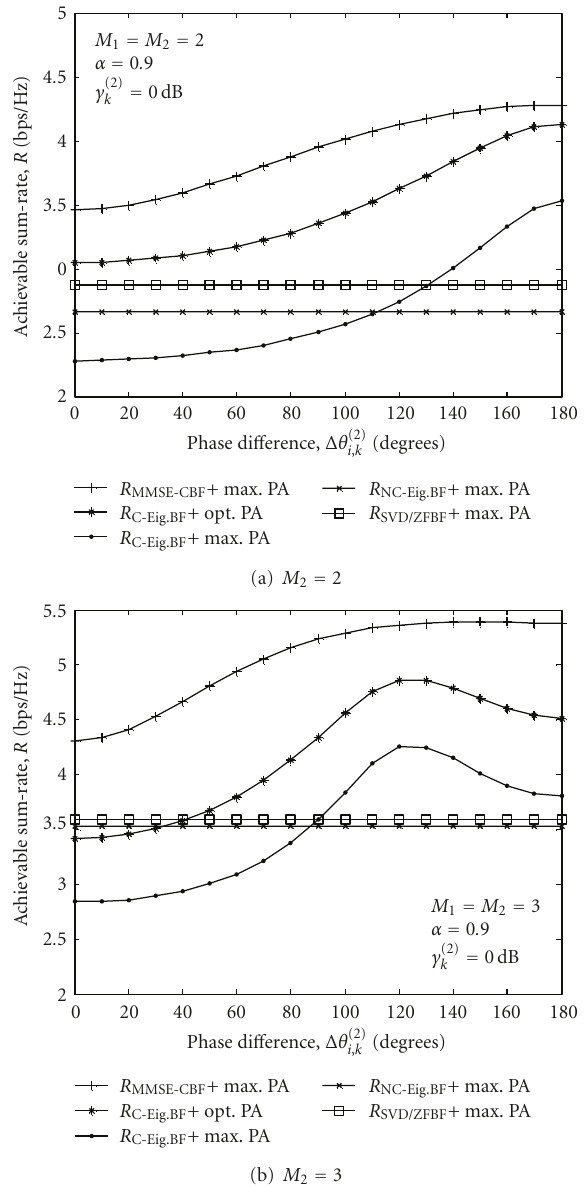
Figure 7: Performance comparison according to Δ θ (2)